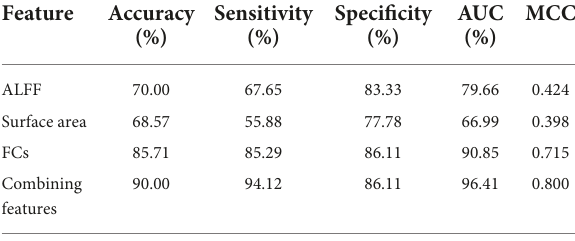
TABLE 5 Results of the discrimination analyses derived from the SVM between HC and CS.